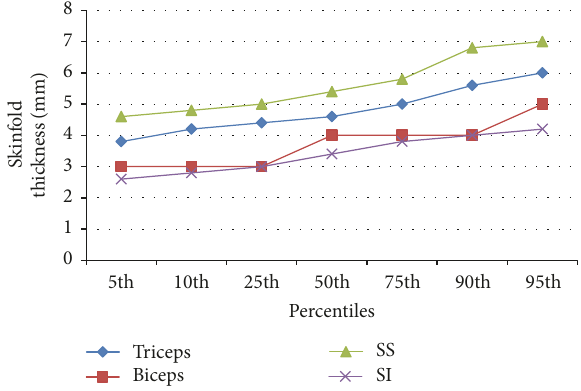
Figure 2: Percentile values for skinfold thickness at various sites in all females.